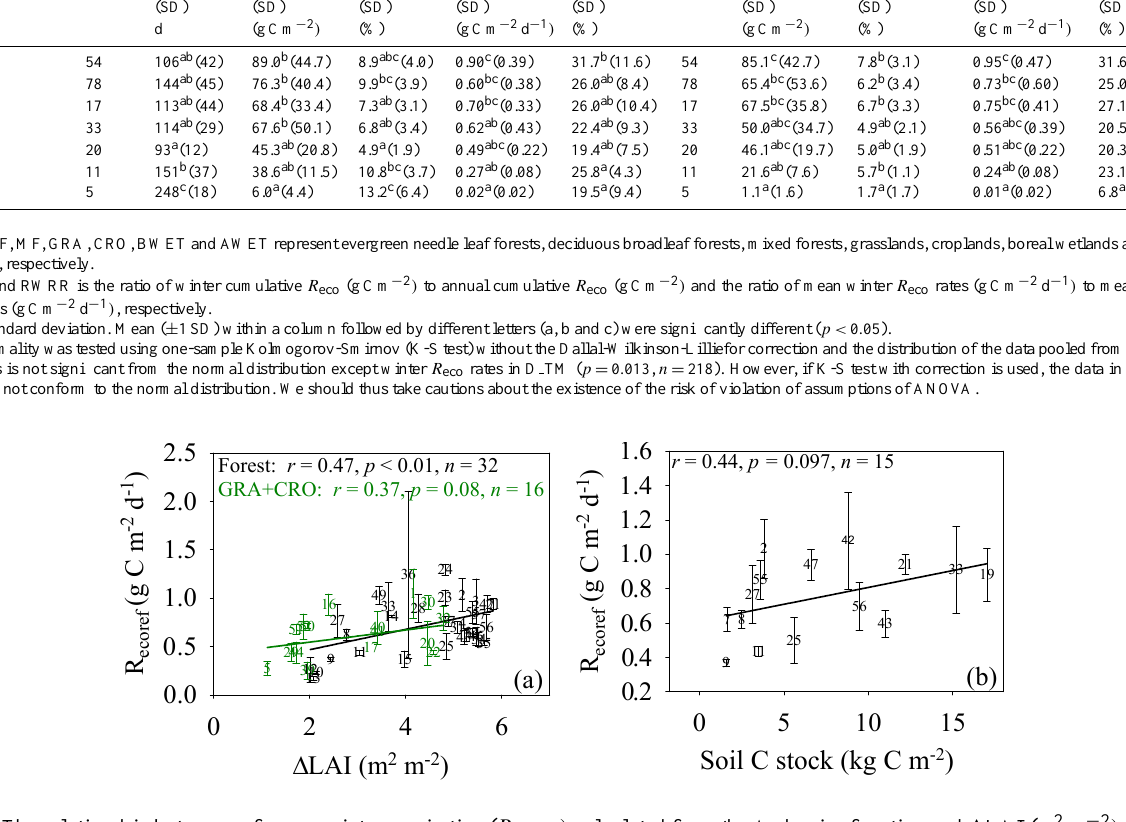
) calculated from the 940 ecoref